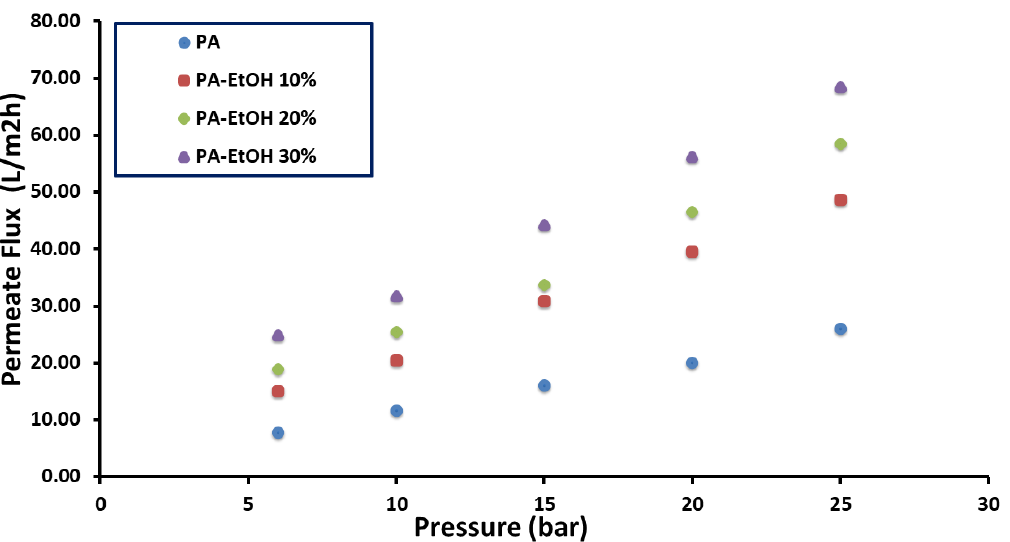
Figure 13. Flux rates plotted against transmembrane pressure of PA and PA-EtOH (10%, 20%, and 30%).